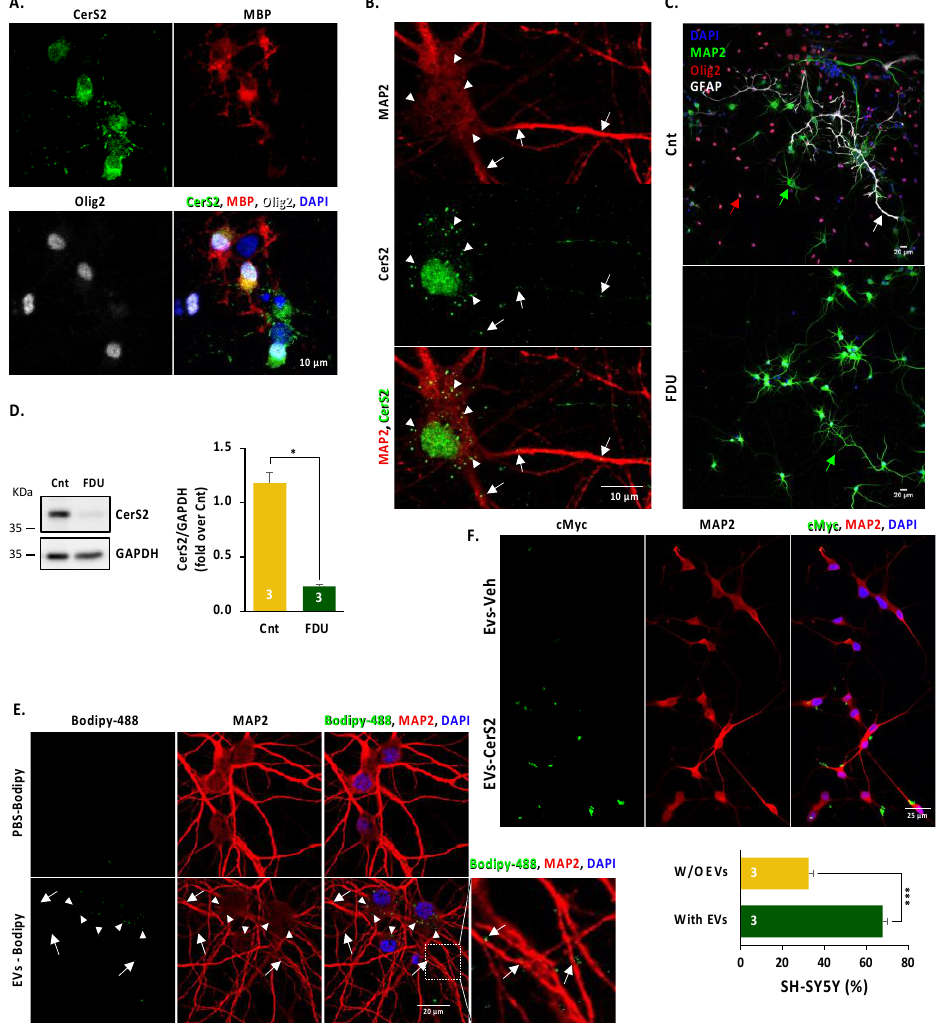
Figure 3. Neuronal CerS2 originated in oligodendrocytes and can be transferred to neurons via EVs. ( A ) Immunolabelling analysis for CerS2 localisation in oligodendrocytes in cortical cultures shows that CerS2 is expressed perinuclearly in mature oligodendrocytes (Olig2 and MBP-positive cells) present in the culture. ( B ) Immunofluorescent analysis for CerS2 localisation in cortical neuronal cultures labelled with MAP2 shows that CerS2 present a punctuate pattern localised in the neuronal somas (triangles) and neurites (arrows). ( C ) Images of 7DIV neuronal cultures treated with vehicle (Cnt) or FDU showing the removal of non-neural cells. Arrows indicate neurons (green), oligodendrocytes (red) and astrocytes (white). ( D ) Representative Western blot image ( left ) and quantification ( right ) of CerS2 in vehicle (Cnt) and FDU-treated neuronal cultures showing a dramatic reduction in CerS2 levels. ( E ) Representative images for cortical primary cultures treated with 1.3 × 10 8 EVs/mL Bodipy (PBS-Bodipy) or EVs-labelled with Bodipy (EVs-Bodipy) showing the neuronal uptake of oligodendrocyte-derived EVs. CerS2 presents a punctuate pattern localised in the neuronal somas (triangles) and neurites (arrows). ( F ) Representative images (upper panels) and quantification (bottom panel) for differentiated SH-SY5Y treated with 1.3 × 10 9 EVs/mL vehicle (EVs-Veh) and CerS2-loaded (EVs-CerS2) EVs neuronal uptake of CerS2 (cMyc) showing that EVs-CerS2 is up taken by differentiated SH-SY5Y. Student t -test. * p -value < 0.05, *** p -value <